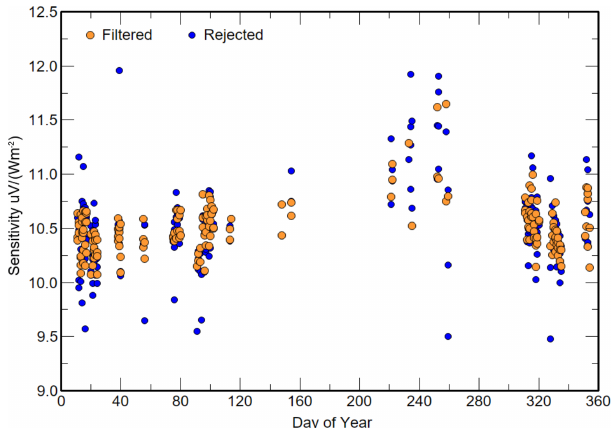
Figure 9. Responsivity <C> values presented in Fig. 6 but filtered for standard deviations of ACP96 τW atm during the cooling and heating period that are less than 0.6Wm − 2 are in gold, and those with higher standard deviations are in